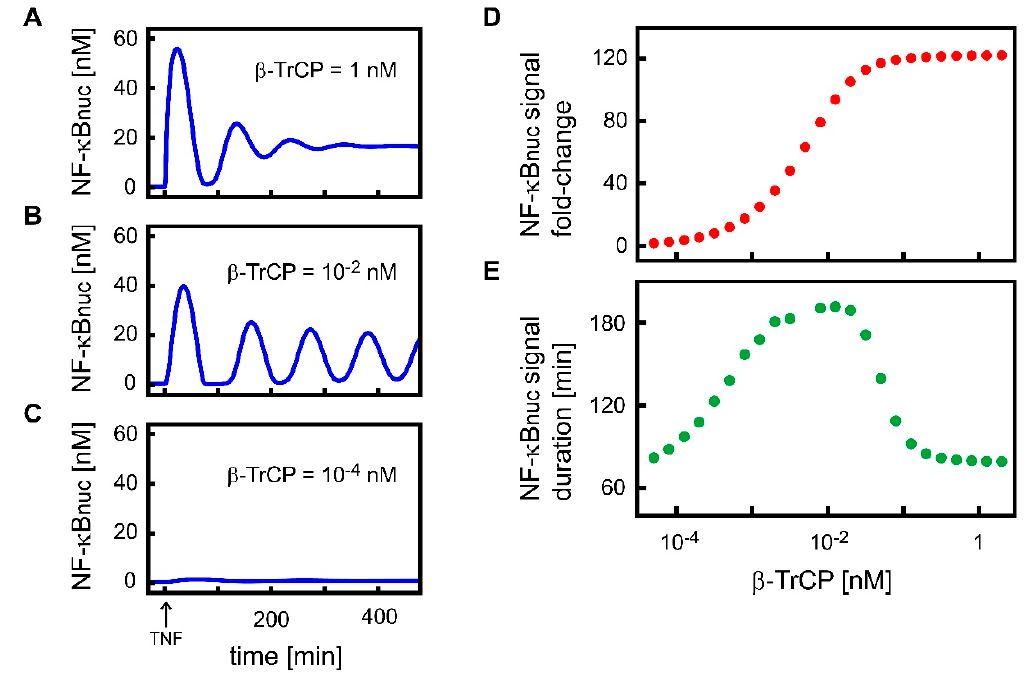
Figure 2. Impact of β -TrCP abundance on the transient dynamics of nuclear NF- κ B upon TNF